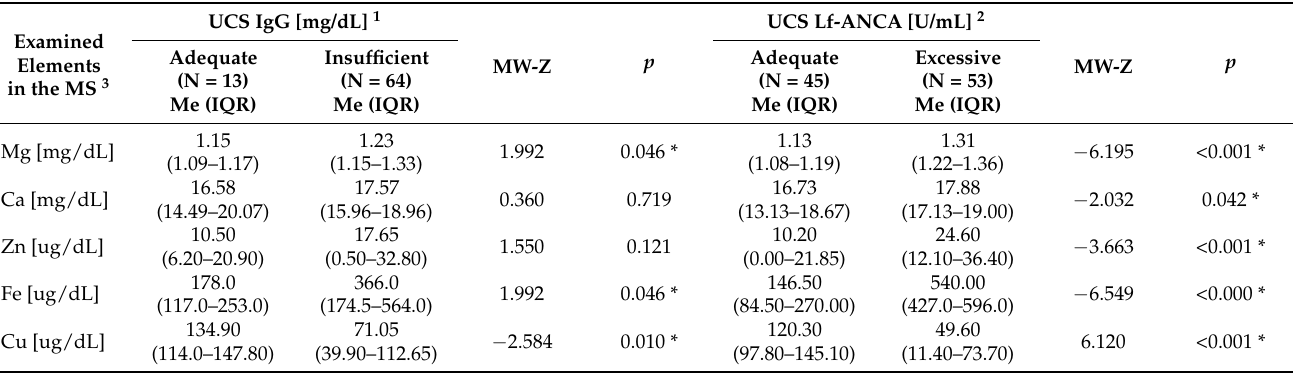
Table 4. Median values of the concentration of macro- and microelements in the MS in relation to the concentration of IgG antibodies and Lf-ANCA auto-antibodies in the UCS (insufficient, adequate and excessive).